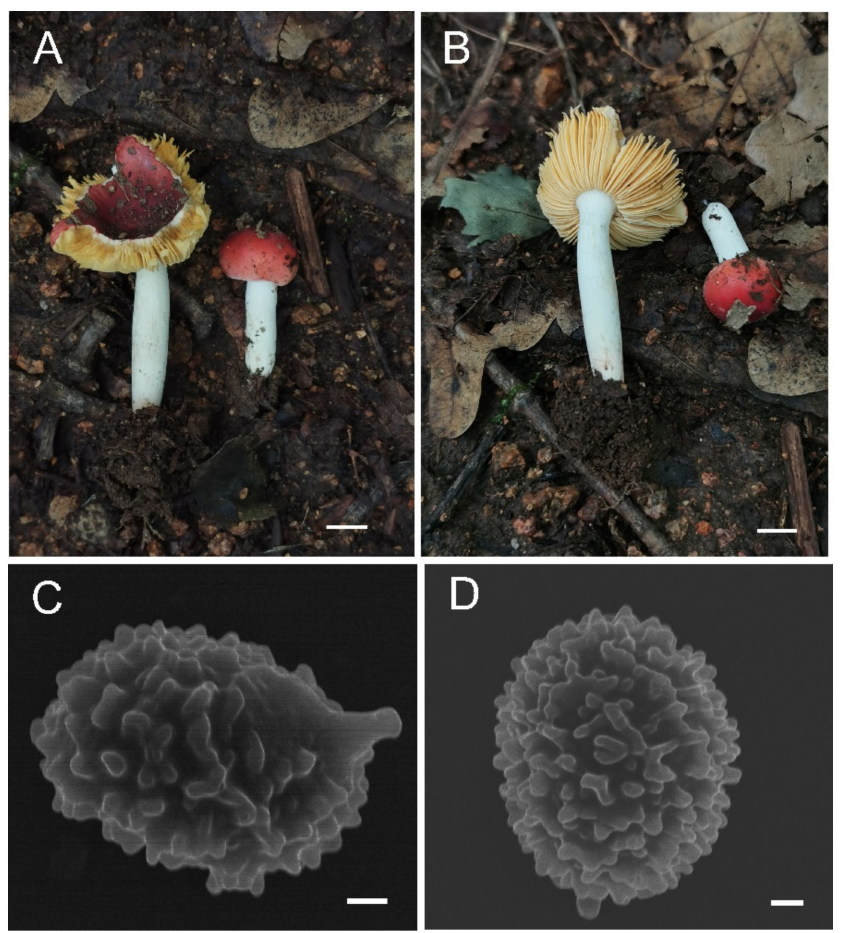
Figure 7. Russula plana (BJTC Z1398). ( A , B ) Basidiomata. ( C , D ) Basidiospores. Scale bar: ( A , B ) = 10 mm, ( C , D ) = 1 µ m. MycoBank: MB 845049 Diagnosis: Russula plana is diagnosed by small-sized basidiomata, brick-red to deep red pileus, large basidiospores ornamented with amyloid warts or spines, suprahilar spot large, smaller basidia, longer terminal cells near the pileus margin, pileocystidia without color change in sulfovanillin. Russula plana and Russula clavatohyphata P. Bhatt, A. Ghosh, Buyck, and K. Das have similar morphological characteristics, but R. plana has brick-red to deep red pileus and small basidia and bigger